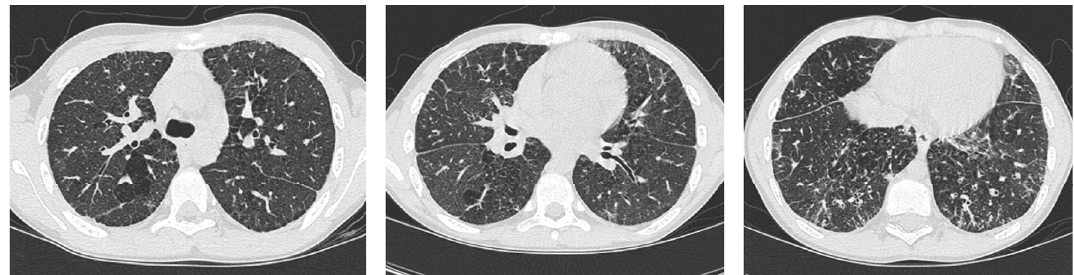
Figure 1: CT of chest showed area of emphysematous changes, several small lung cysts, patchy ground-glass opacity, interlobular septal thickening, and bronchiectasis.